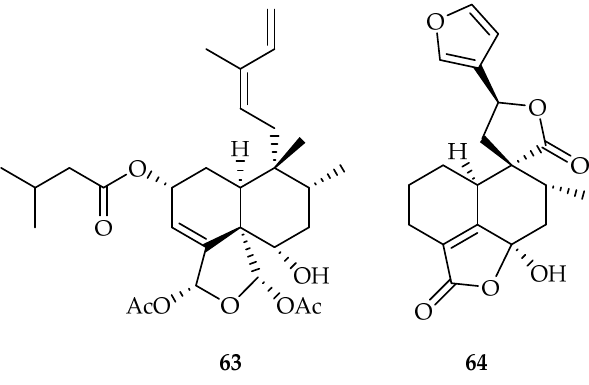
Figure 27. Structures of graveospene A 63 [42] and cracroson F 64 [43].